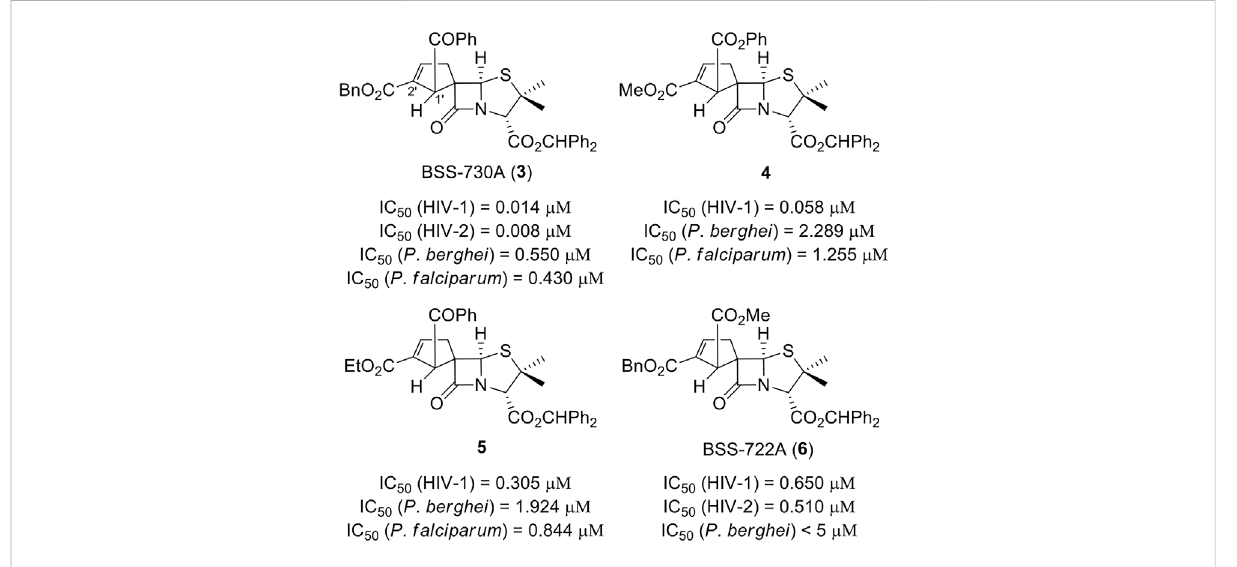
FIGURE 2 Spirocyclopentene- β -lactams with potent activity against HIV and Plasmodium